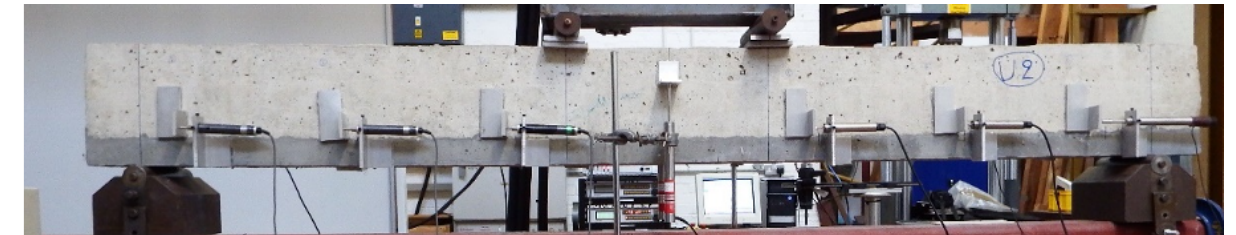
Figure 5. Experimental setup for the testing of the beams.